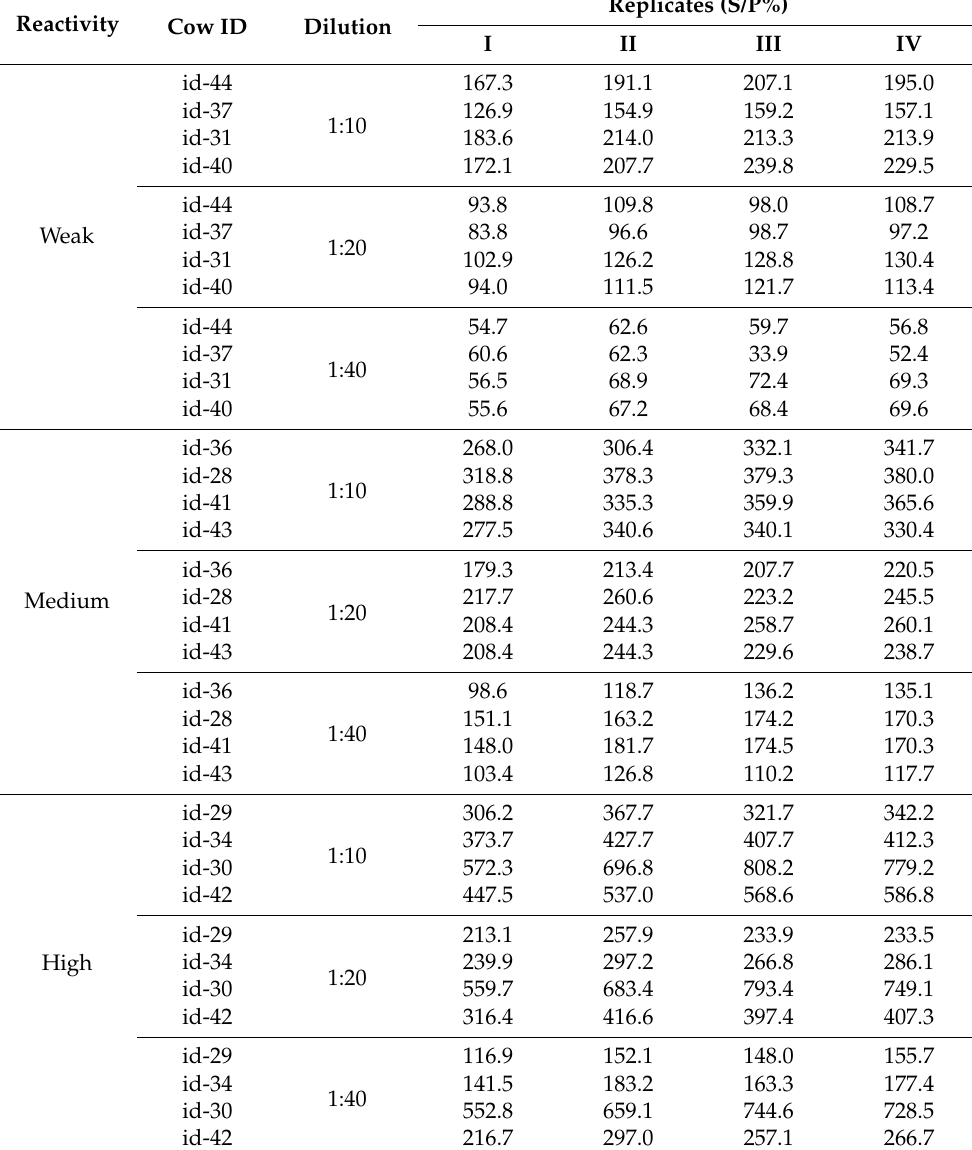
Table 4. Results obtained from gE indirect ELISA using positive reference samples assayed in four